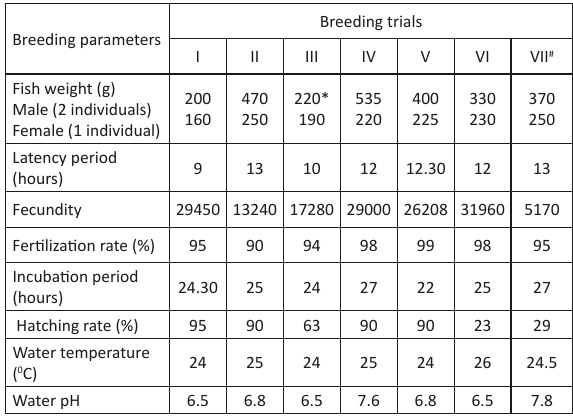
Table 1. Selected breeding trials of Horabagrus brachysoma carried out during 2004-2005 using Ovaprim @1ml -1 as the inducing agent